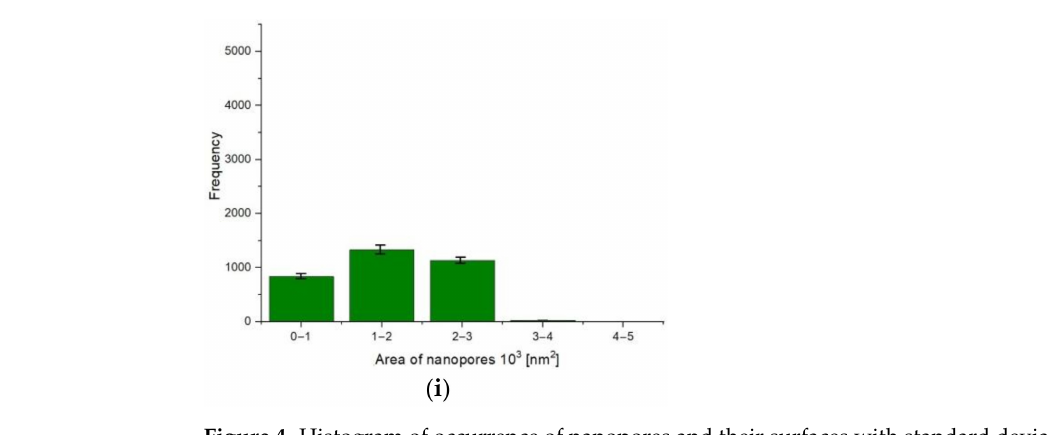
Figure 4. Histogram of occurrence of nanopores and their surfaces with standard deviations: ( a ) Sam- ple A; ( b ) Sample B; ( c ) Sample C; ( d ) Sample D; ( e ) Sample E; ( f ) Sample F; ( g ) Sample G; ( h ) Sample H; ( i ) Sample I.